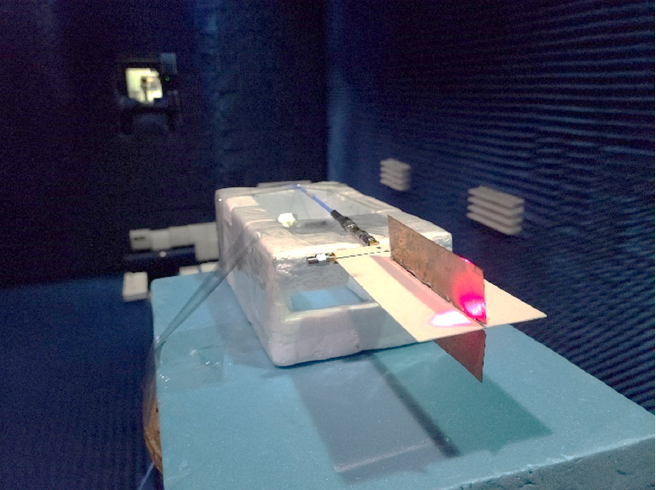
Figure 11. The measurement setup in the anechoic chamber.